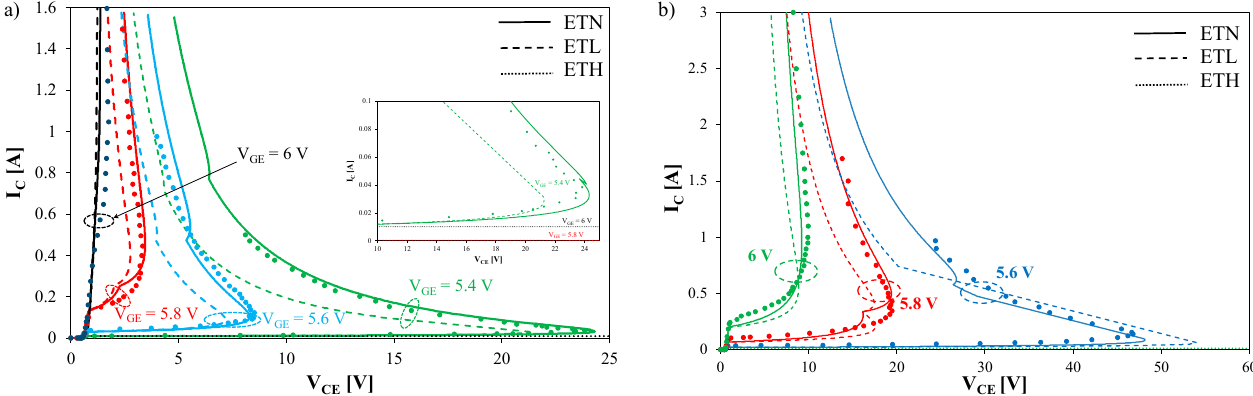
Figure 5. Computed and measured transfer characteristics of the tested transistor.